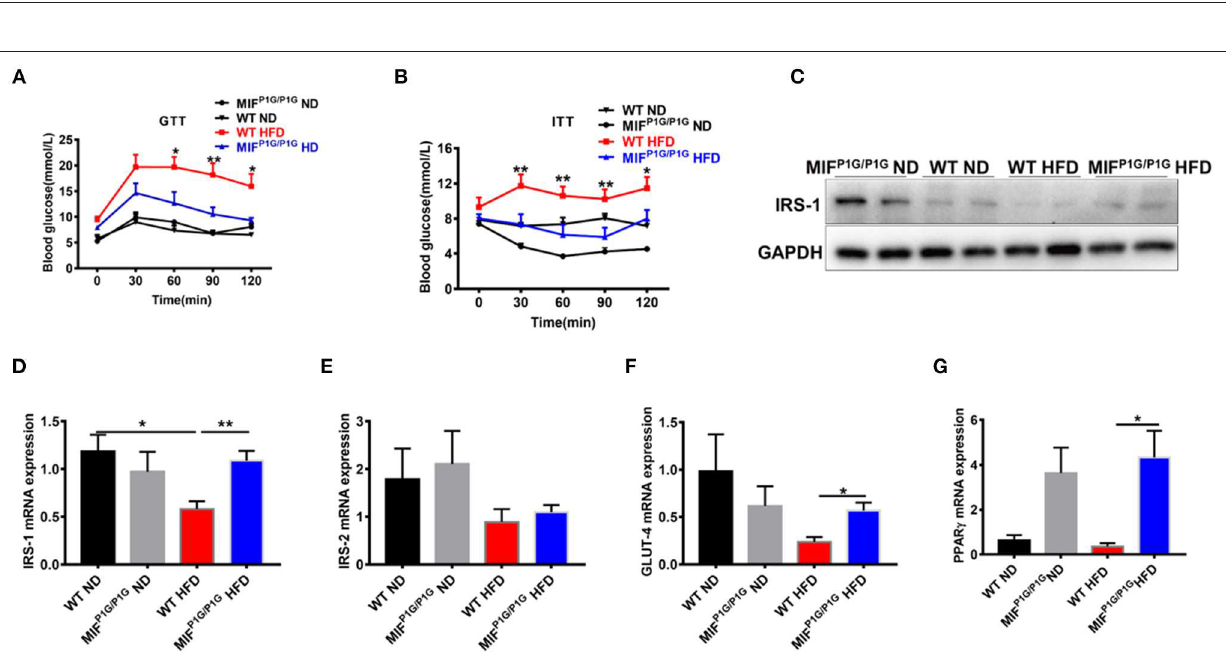
Frontiers in Endocrinology |